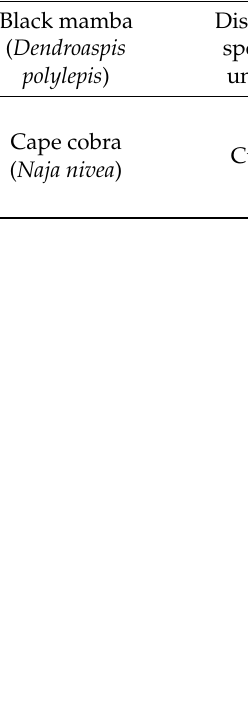
Table 12. Clinical features of chromatophoromas in the reptile family: Testudinidae